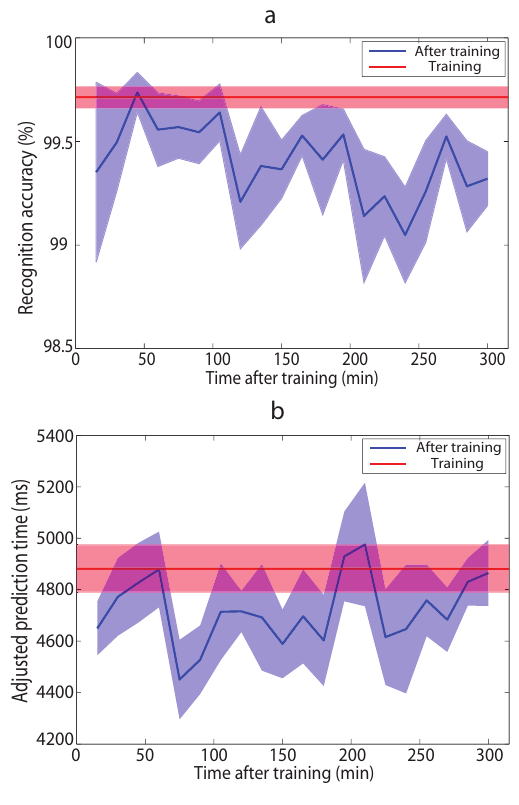
Figure 6. Average recognition accuracy ( a ) and adjusted prediction time ( b ) over seven able-bodied subjects with some time ranging from 15 min to 300 min after training. Color shades denote SEMs across